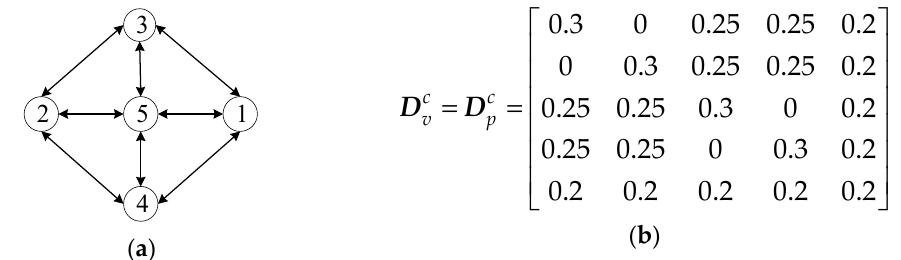
Figure 14. Plug and play performance of the proposed scheme. ( a ) the output power of each generator; ( b ) the incremental cost of each generator; ( c ) the estimated voltage in each voltage regulator; ( d ) the bus voltages; ( e ) the average voltage of the system.